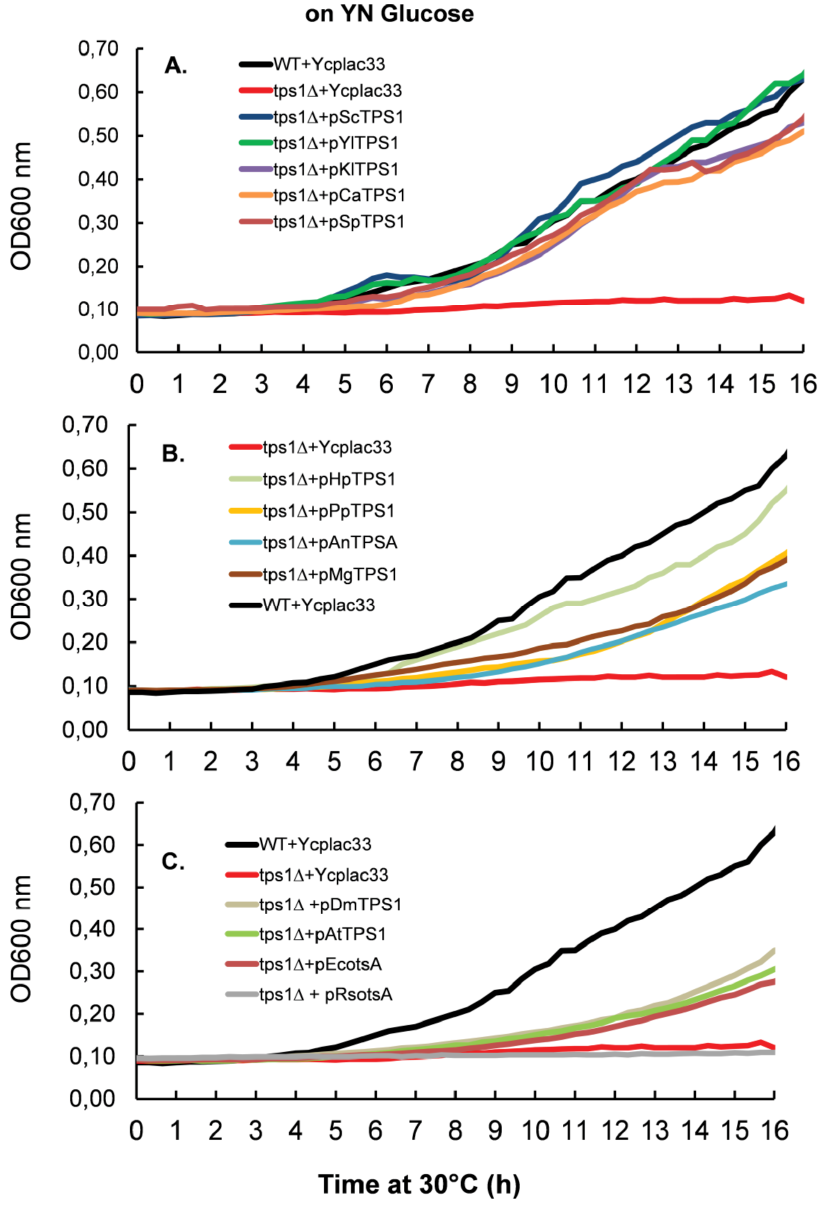
FIGURE 3 : Resumption of growth of S. cerevisiae tps1 mutant transformed with TPS1 from different organism on YN glucose media in microtiter plate. (A) Complementation of sctps1 with TPS1 homologs from yeast species. (B) Complementation of Sctps1 with TPSD1 homologs from P. pastoris , H. polymor- pha and the filamentous fungi A. niger and M. grisea . (C) Complementation of sctps1 with TPS1 homologs from bacte- ria, plants and drosophila. The experi- mental design was as in Figure 2 except that the yeast cells were inoculated in 250 µL of YN containing glucose at 2% (w/v). Results shown are the mean of two independent experiments. For the sake of clarity, standard deviation bars have been withdrawn, but overall the SD was in the range of 10 - 15